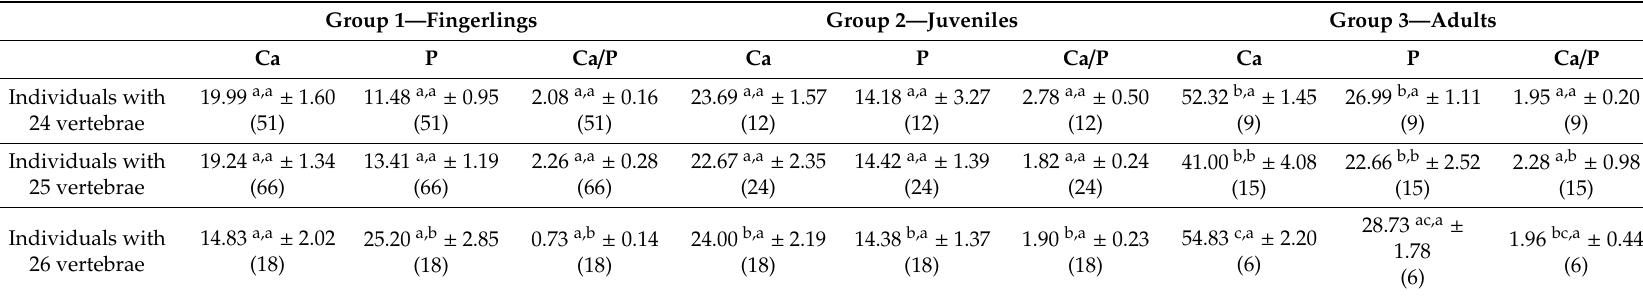
Table 4. The Ca (% At) and P (% At) levels and Ca / P ratio of the 10th vertebra of the European seabass grouped by age and number of vertebrae. Group 1—Fingerlings Group 2—Juveniles Group